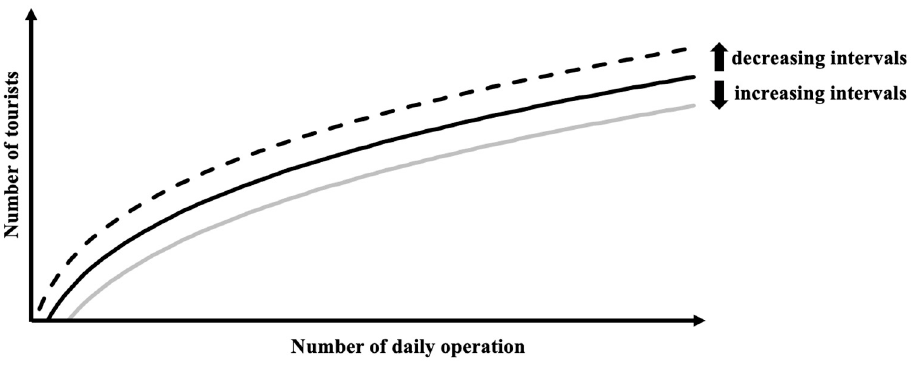
Figure 3. Tourist demand rates per day.